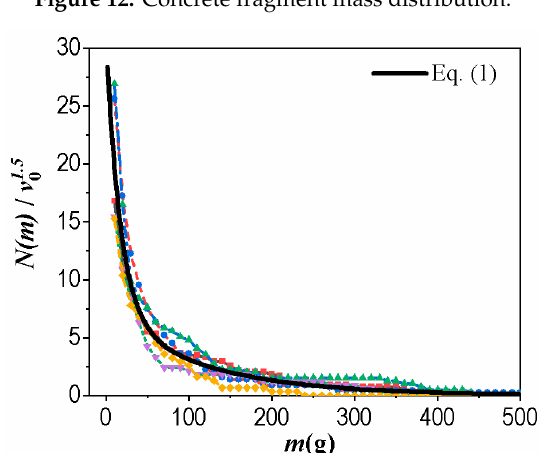
Figure 13. Results of the normalization of the mass distribution on the vertical axis.